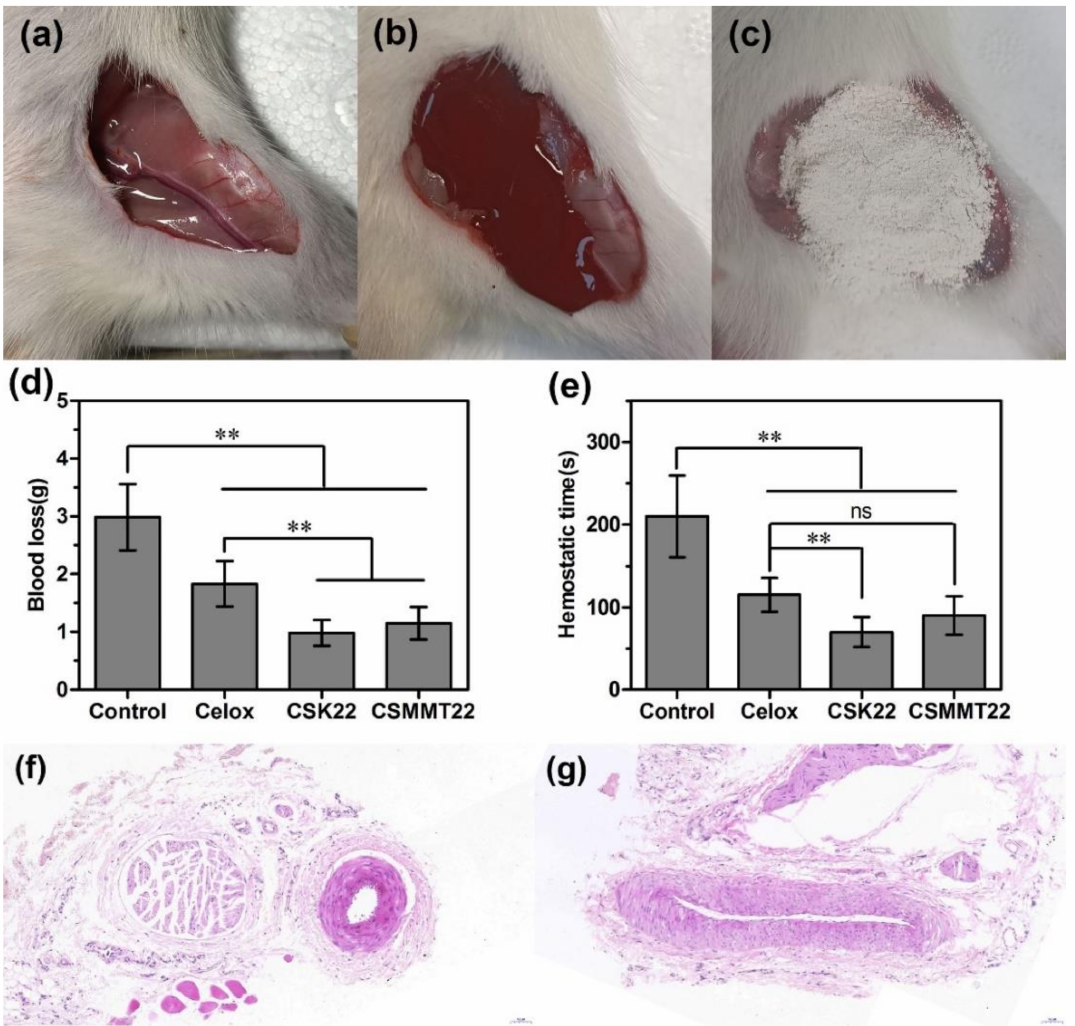
Figure 8. ( a ) Photographs of the rat femoral arteriovenous injury model, ( b ) transected arteriove- nous that caused hemorrhage, and ( c ) staunch bleeding after filling the wound; ( d ) blood loss and ( e ) hemostatic time of control, Celox, CSK22, and CSMMT22. Data represent the mean ± SD ( n = 6). ** p < 0.01; ns p > 0.05, compared with the two groups. Histological analysis of rat femoral arteriove- nous injury (magnification, × 20), ( f ) arteriovenous treated with CSK22, and ( g ) arteriovenous treated with